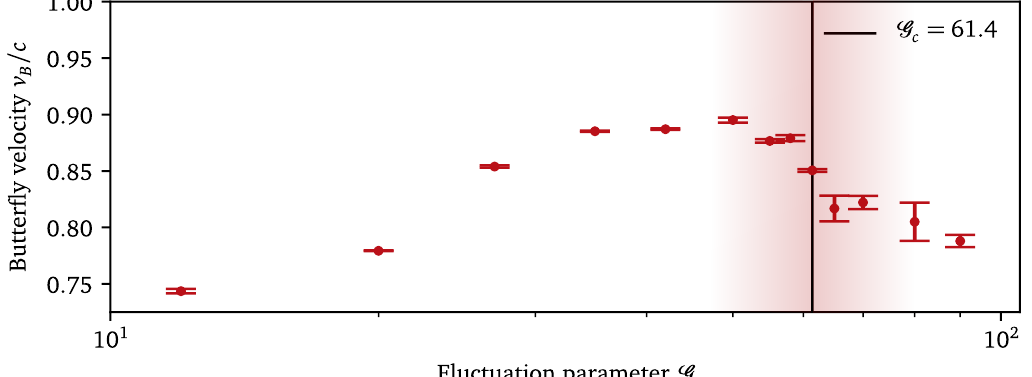
Figure 6: Butterfly velocity. The velocity associated to the ballistic spreading of the OTOC exhibits a global maximum on approach to the phase transition at and is considerably smaller than the speed of light c for a wide range of values for G . Different behaviour is seen on both sides of the phase transition: While the butterfly velocity is slowly rising upon approaching the phase transition from the paramagnetic phase, it steeply decreases as one moves away from it into the symmetry broken phase. The red shading indicates the range of G in which critical slowing down was found in the spectral function. Error bars are obtained from a jackknife binning